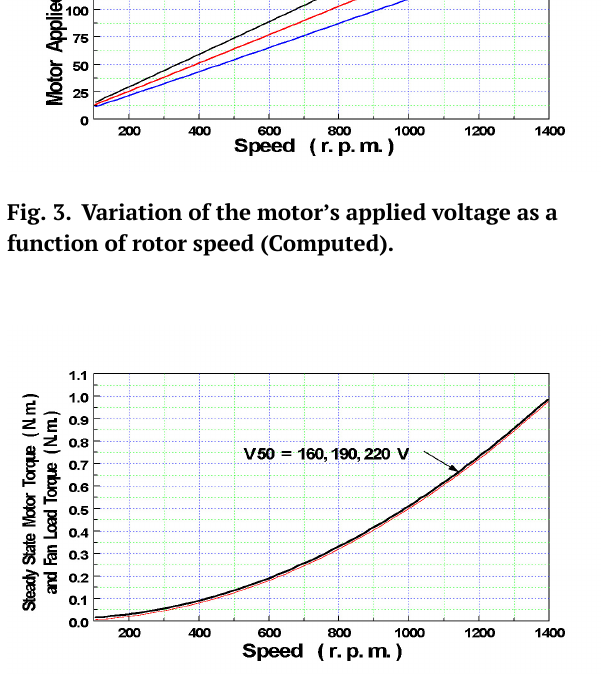
Fig. 4. The variation of steady-state torque and load torque in terms of speed (Computed).